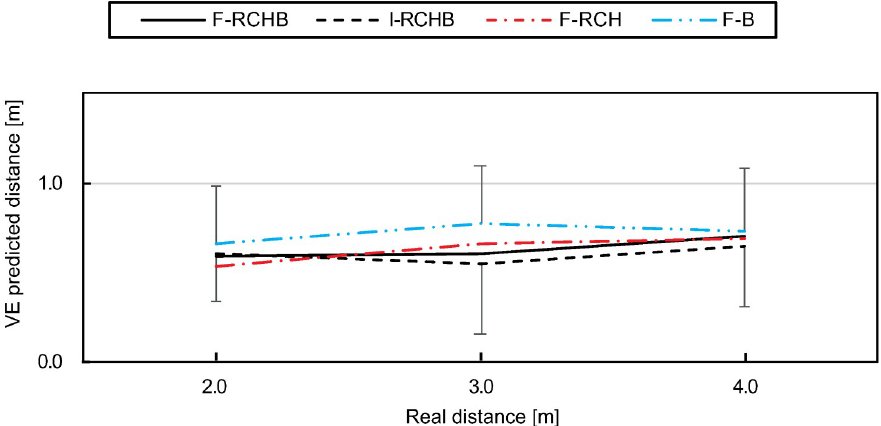
Fig 17. Variable error. Mean and standard deviation of the variable error of the predicted putting distance under the I-RCHB, F-RCHB, F-RCH, and F-B conditions.